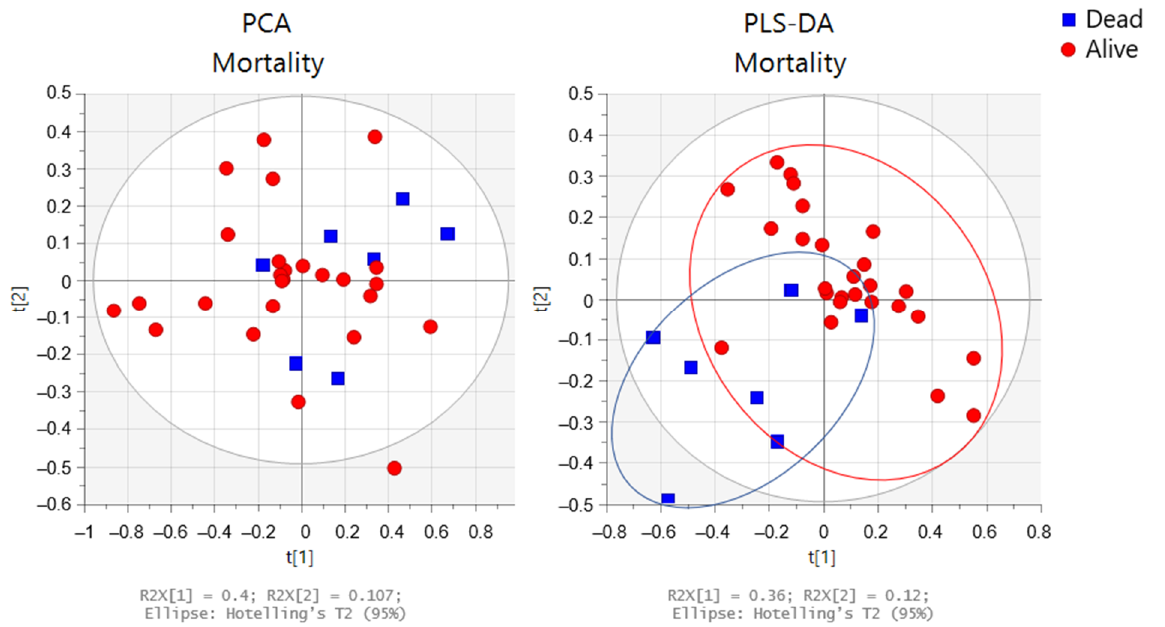
Figure 8. Multivariate analysis obtained from the baseline urine spectra from patients who remained alive (n = 26) (red circles) or died (n = 7) (blue squares) during the two-year study. Score plots from the PCA ( left side) and PLS-DA ( right side).